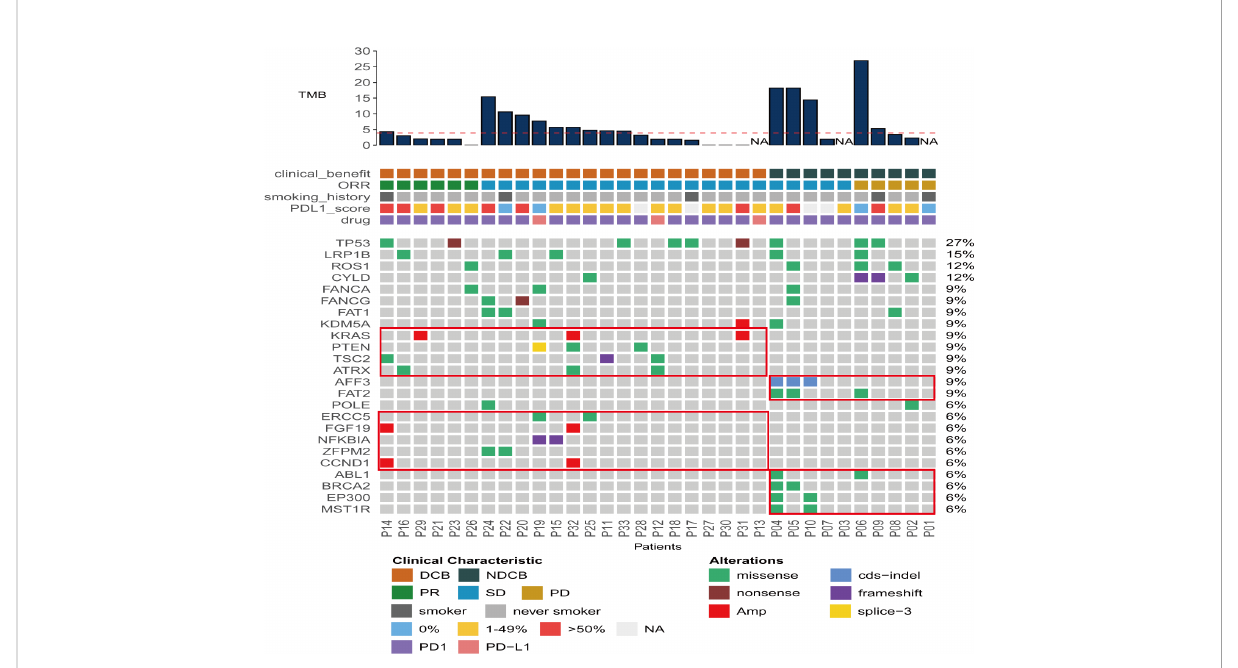
FIGURE 4 Gene mutation landscape of 33 ICI-treated PLELC patients. Distributions for individual gene mutations in the study cohort as assessed by next- generation sequencing (NGS). Each column represents one patient. Clinical characteristics and NGS-assessed TMB values for each patient are shown on